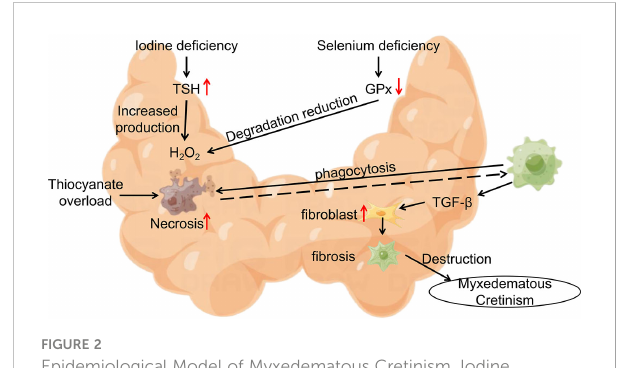
FIGURE 2 Epidemiological Model of Myxedematous Cretinism. Iodine de fi ciency, Se de fi ciency and thiocyanate overload are involved in the pathogenesis of myxedematous cretinism. TSH, Thyroid Stimulating Hormone; GPx, glutathione peroxidase; TGF- b , transforming growth factor- b